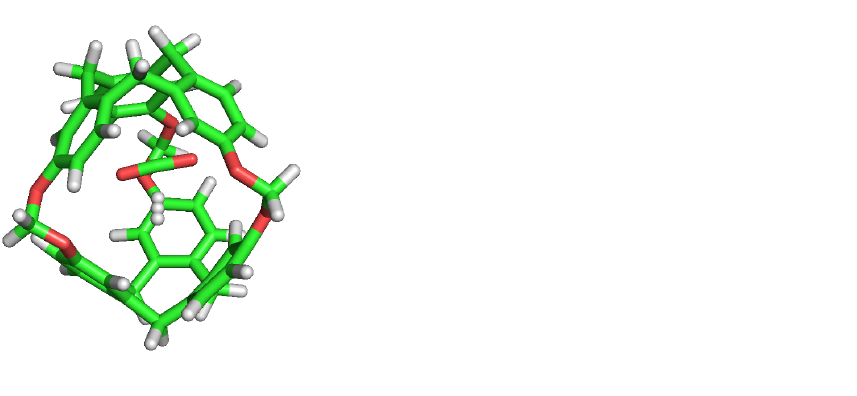
Figure 7. CO 2 and H 2 sharing the same cavity during a ST2 series simulation.